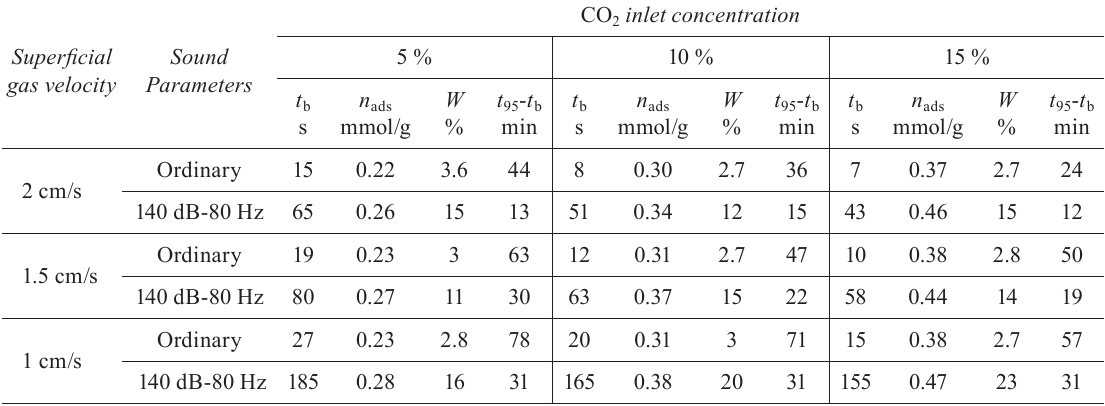
Table 1 Results of CO 2 adsorption tests.